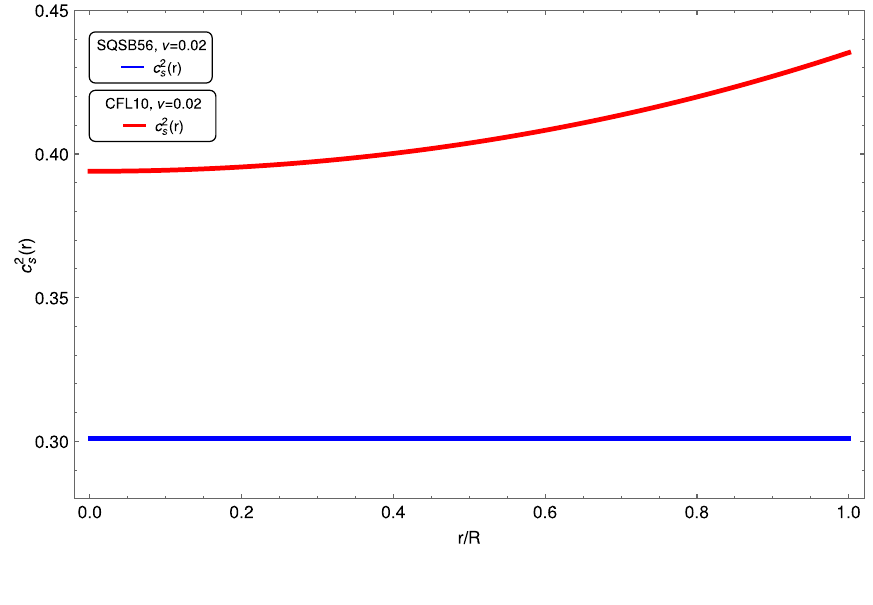
for comparison reasons. Left panel M R profiles (mass in solar masses and radius in km). Right panel Compactness C = G N M / R vs mass (in solar masses)